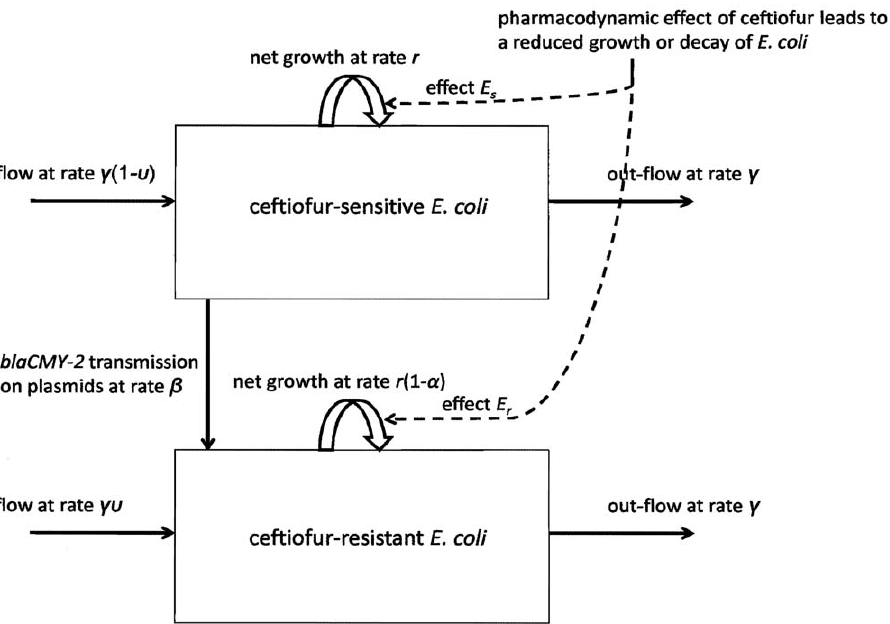
Figure 1. Flow-chart of the model of the dynamics of ceftiofur-sensitive and resistant commensal E.coli in the cattle large intestine. Bacterial growth is density-dependent with fractional net growth rate r ; fitness cost for cells with blaCMY-2 -carrying plasmids manifests as a reduction a in r . Resistant cells transfer blaCMY-2 to the progeny during cell division. Horizontally, blaCMY-2 is transferred to the sensitive cells at rate b ; the transmission is frequency-dependent with the total of b * N r * N s / N . There is fractional in-flow and out-flow of E. coli at rate c ; fraction u of in-flowing E. coli are ceftiofur-resistant. Antimicrobial action of ceftiofur metabolites, depending on their concentration, results in either reduced growth or decay in number of E. coli .